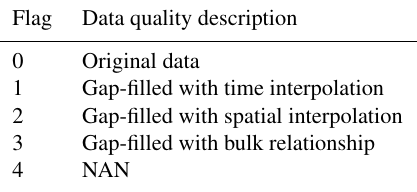
Table 3. A list of data quality